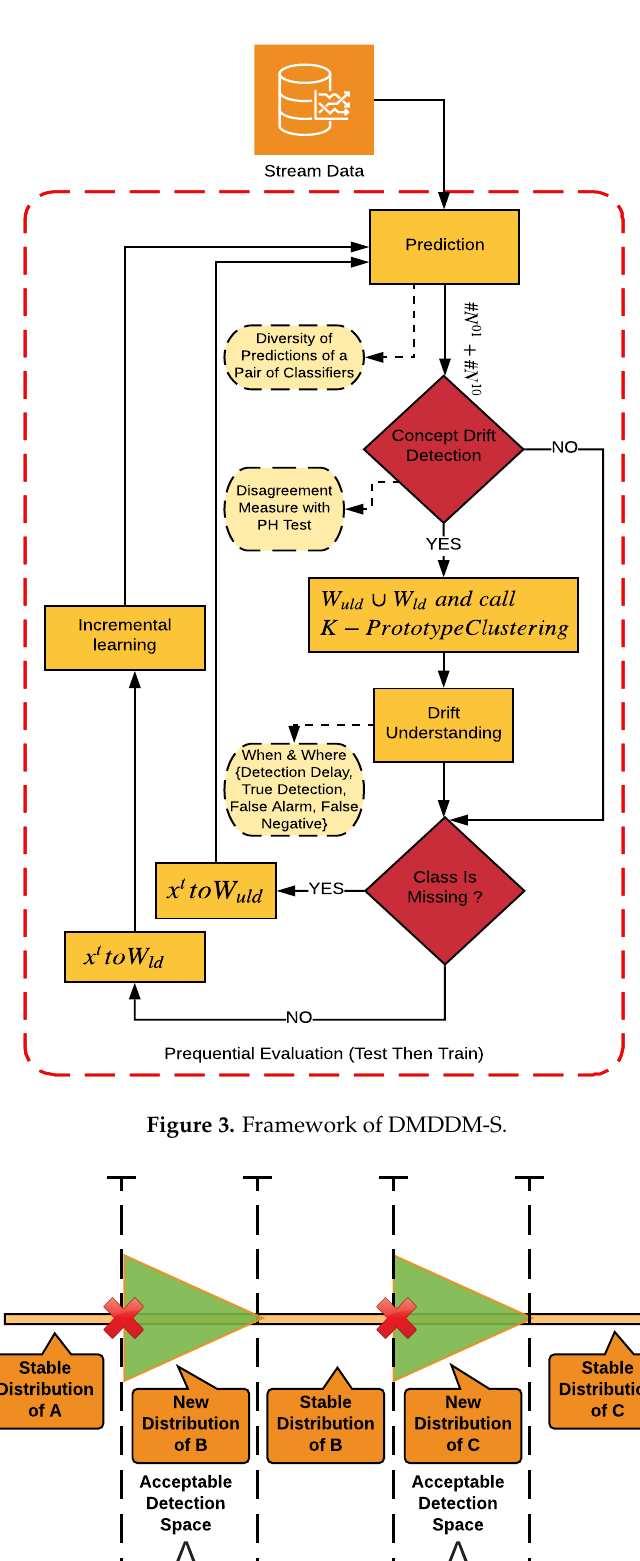
Figure 4. Illustration of the DMDDM-S